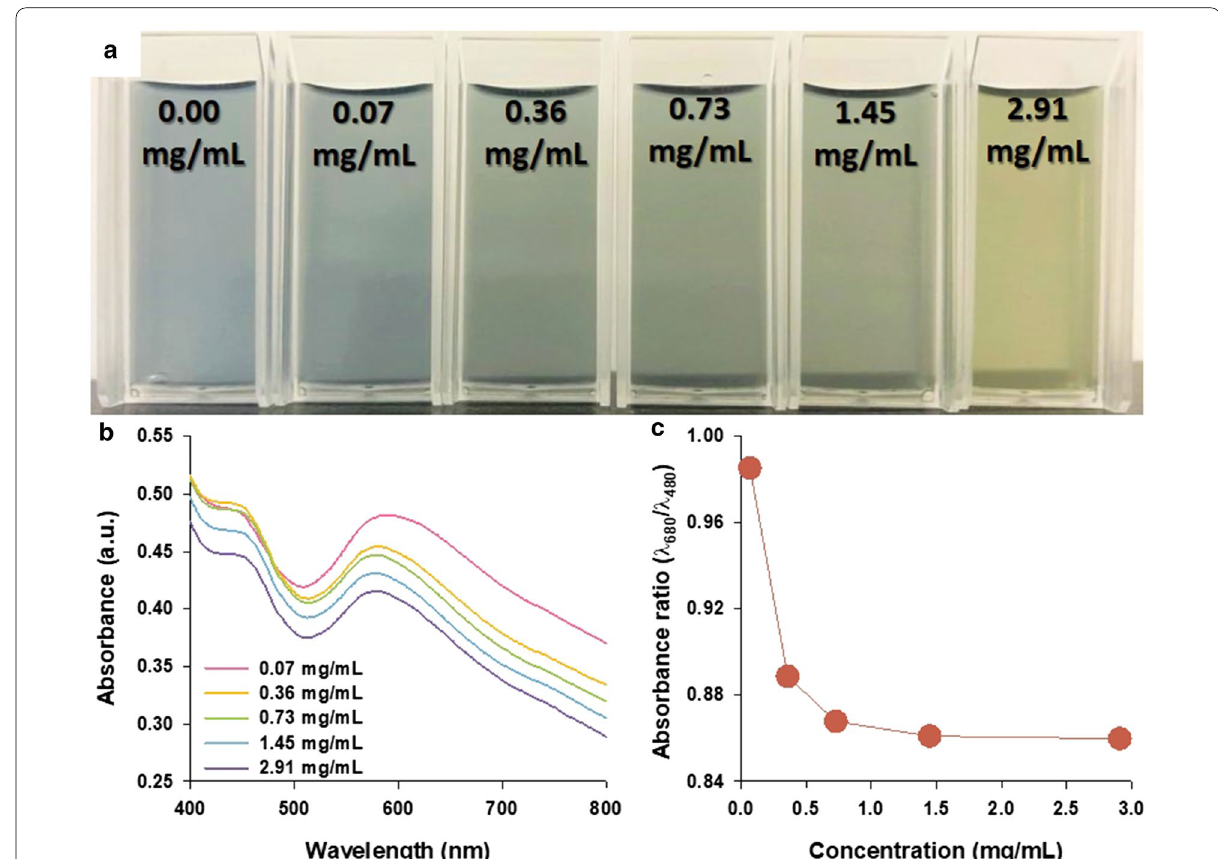
Fig. 5 a A photograph, b absorbance spectra, and c absorbance ratio for representative wavelengths for EB (at 680 nm) and ES (at 480 nm) states of PANS solutions with indicated glucose